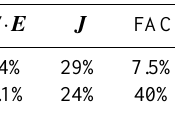
Table 2. Errors in the (cid:127) -band results calculated by the KRM and CECS methods. Error is calculated using Eq. (24) and data pre- sented in Figs. 6 and